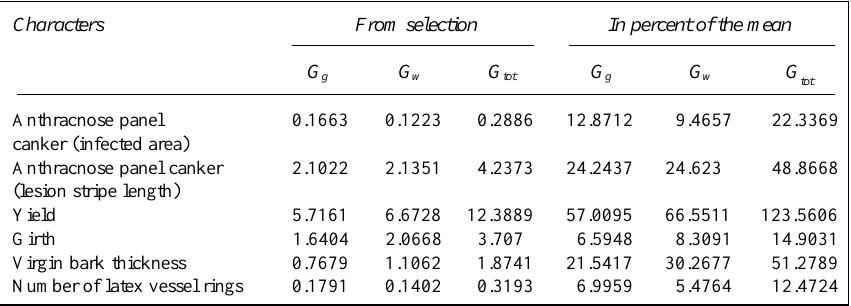
Table VI - Expected gains from selection and percentage of the mean among (G g ) and within (G w ) progenies selection and total (G tot ) for six different characters in 18 open-pollinated progenies of rubber tree (Hevea brasiliensis) .